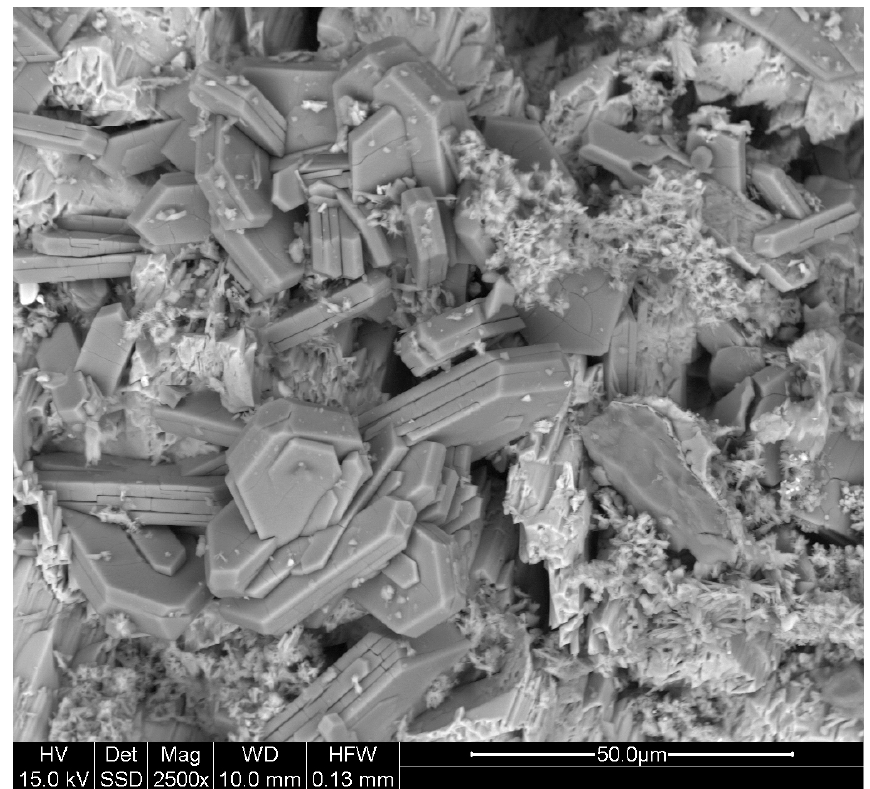
Figure 3. Back-scattered electron image of pleysteinite crystals, showing dehydration cleavage in the vacuum of the electron microscope.